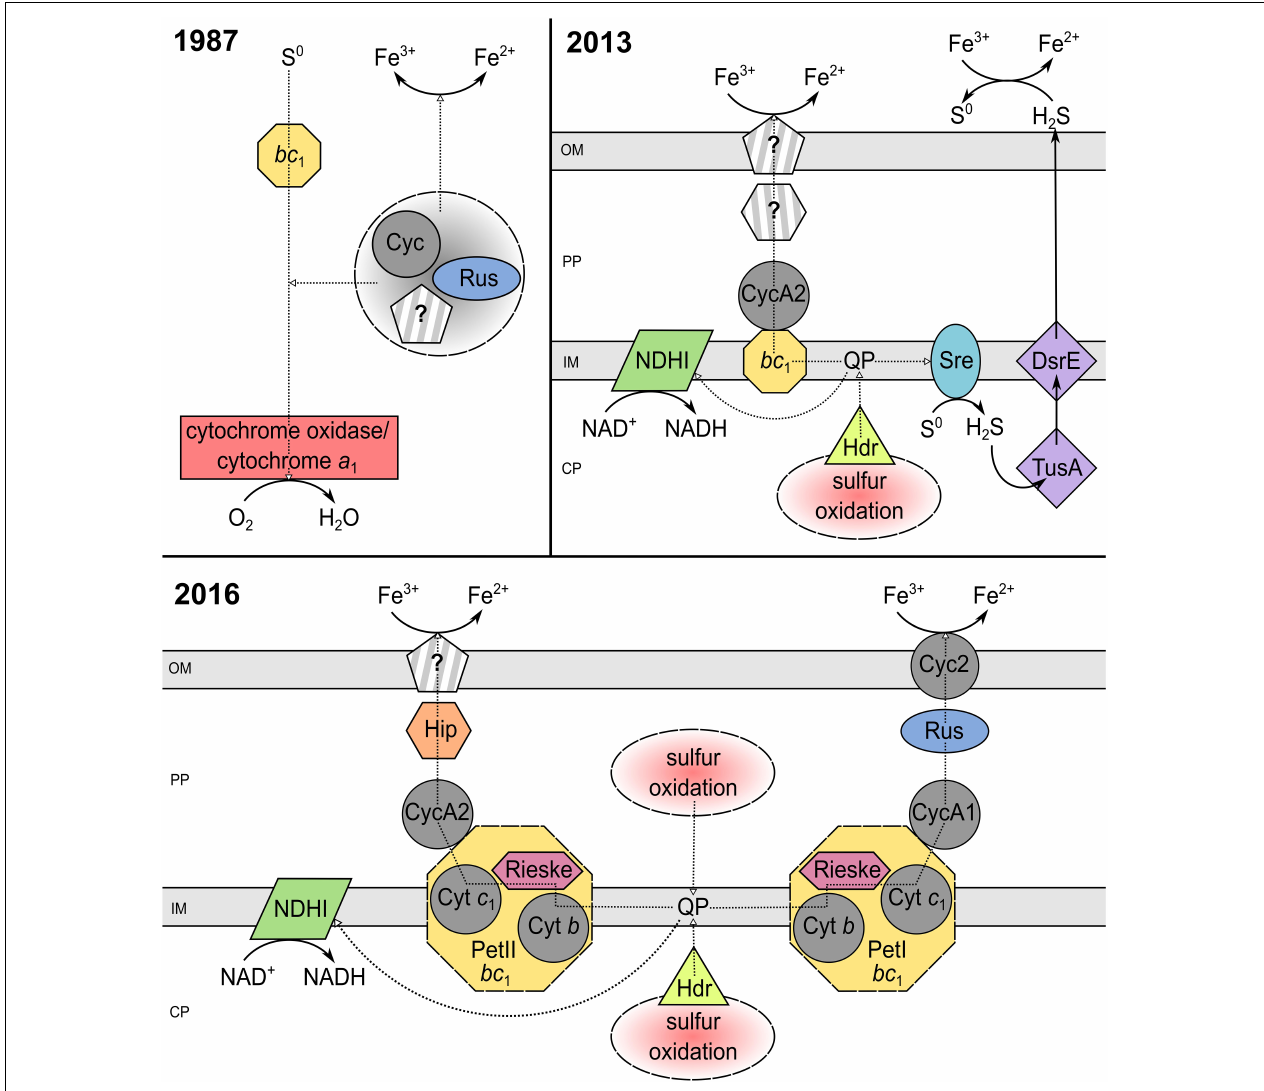
FIGURE 3 | Elucidation of the iron reduction mechanism coupled to sulfur oxidation by Acidithiobacillus ferrooxidans from 1987 to 2016. The underlying models of Corbett and Ingledew (1987); Osorio et al. (2013), and Kucera et al. (2016a) were modified to a consistent style. PP, periplasm; CP, cytoplasm; OM, outer membrane; IM, inner membrane; Cyt, cytochrome; Cyc, cytochrome c ; QP, quinol pool; Rus, rusticyanin; NDHI, NADH dehydrogenase complex; bc 1 , cytochrome bc 1 complex (encoded by petI/II ); Sre, sulfur reductase; DsrE/TusA, conserved hypothetical protein (likely sulfur transferase); Hdr, heterodisulfide reductase; Hip, high potential iron-sulfur protein; Rieske, Rieske iron-sulfur protein; ?, unidentified pathway